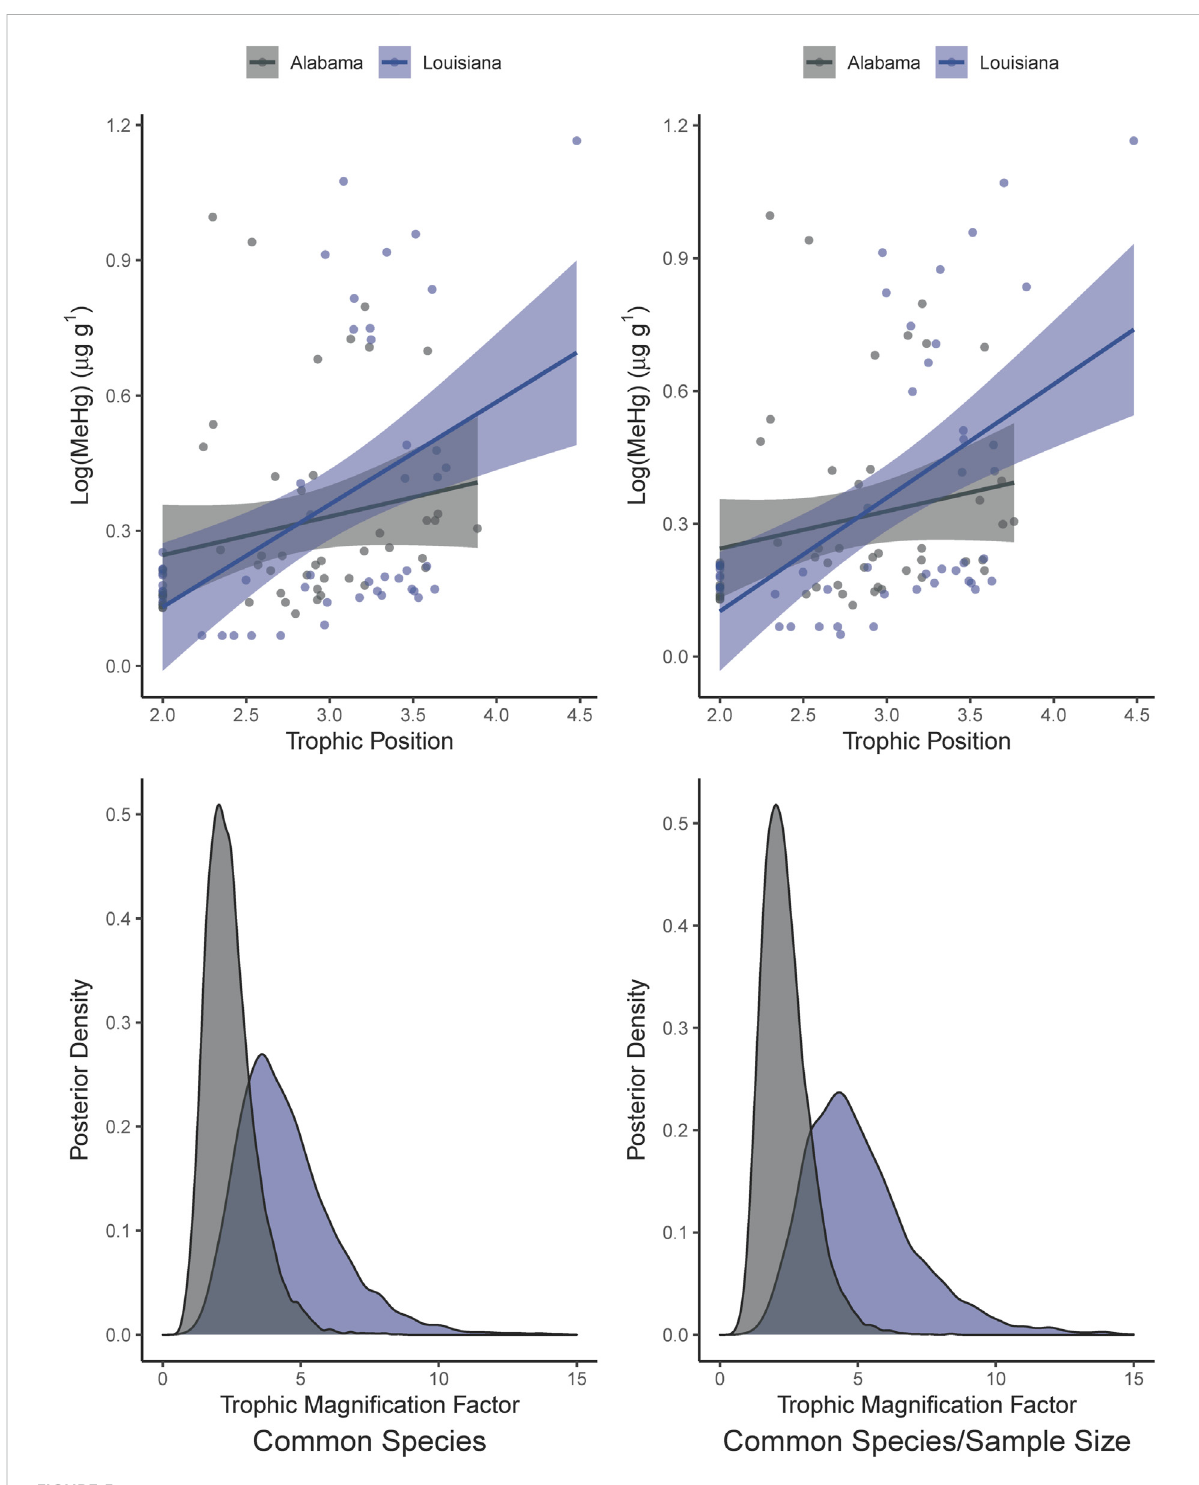
FIGURE 5 The relationship between consumers ’ MeHg (log-transformed) burden and trophic positions and estimated posterior distributions of trophic magni fi cation factors (TMF) in Louisiana and Alabama using common species but differing samples sizes or common species and standardized samples